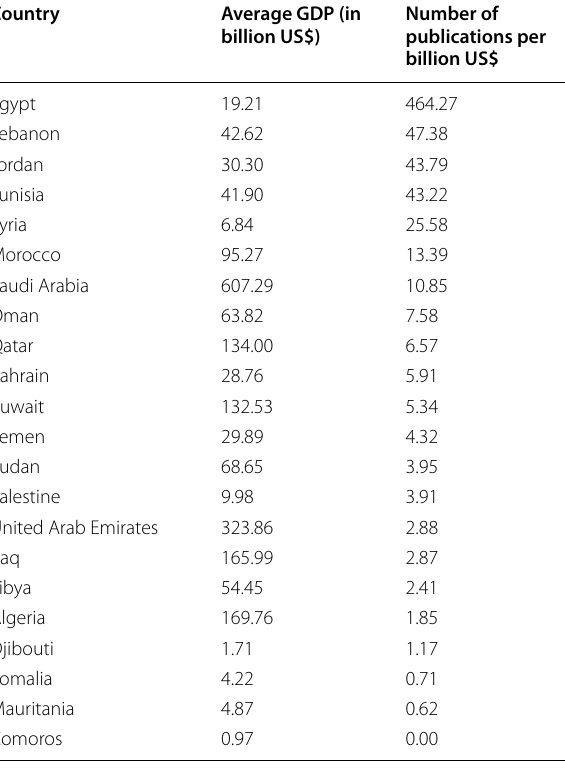
Table 2 Number of cancer-related articles per million persons